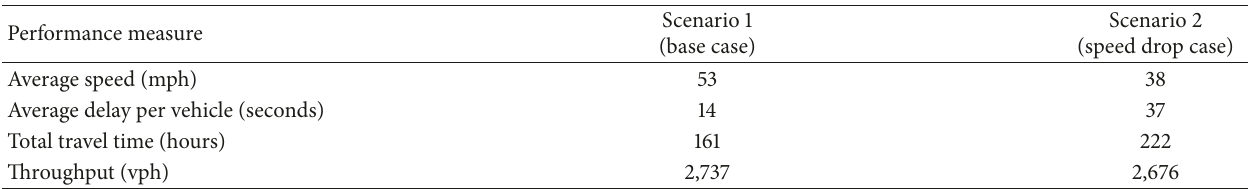
Table 1: Network performance with and without a speed reduction zone.